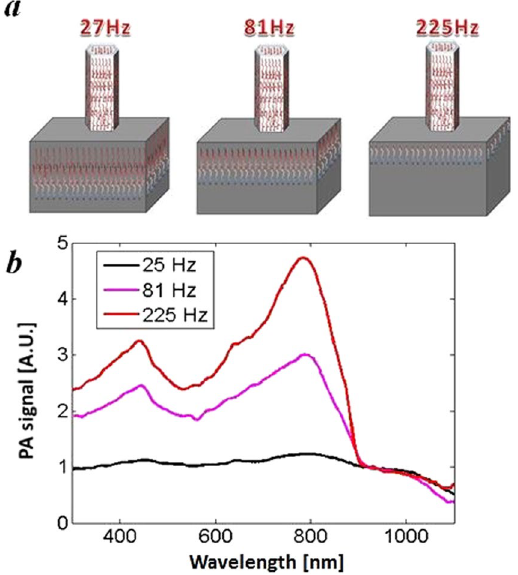
Figure 5. ( a ) Schematic of a different surface / NW contributions for different frequencies: at the lowest 27 Hz the PA signal mainly originates from Si substrate, while at the highest 225 Hz it mainly originates from NW absorption. ( b ) PA spectra for three different frequencies that correspond to the different contribution of the sample surface for sample B. At the highest frequency 225 Hz we observe the resonant peak corresponding to the excitation of HE11 mode.